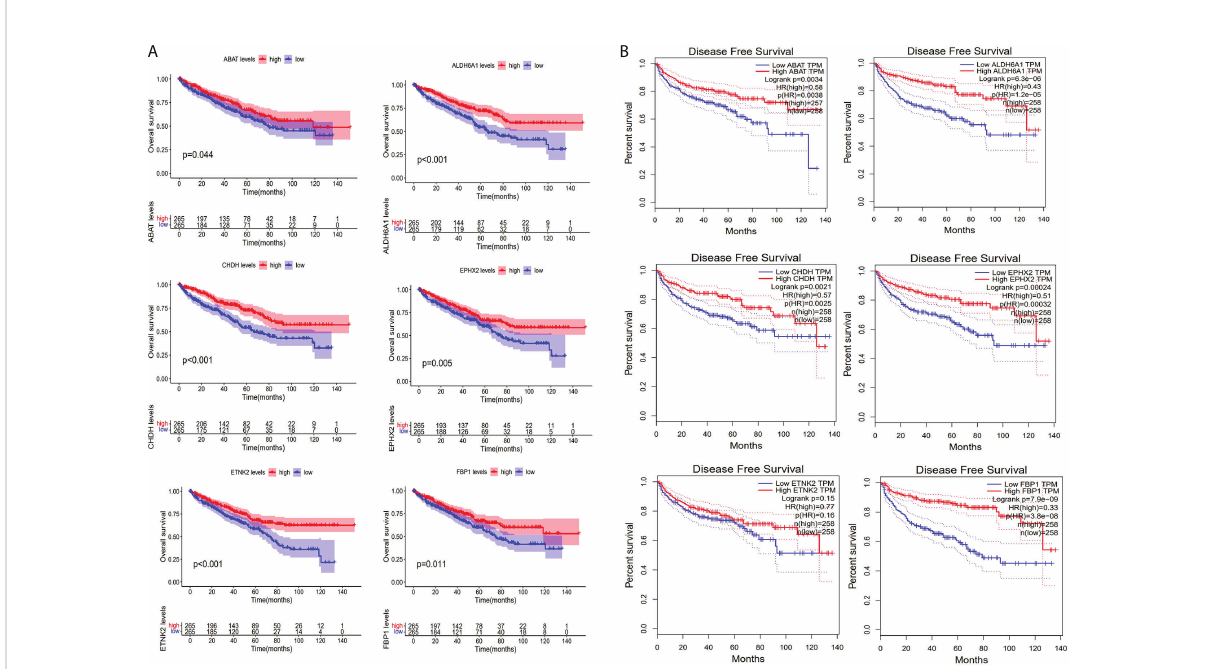
FIGURE 6 Evaluation of survival. (A) Kaplan-Meier survival curves for the six key genes based on the TCGA-KIRC cohort. (B) Disease-free survival curves for the six key genes based on Gene expression pro fi ling interactive analysis